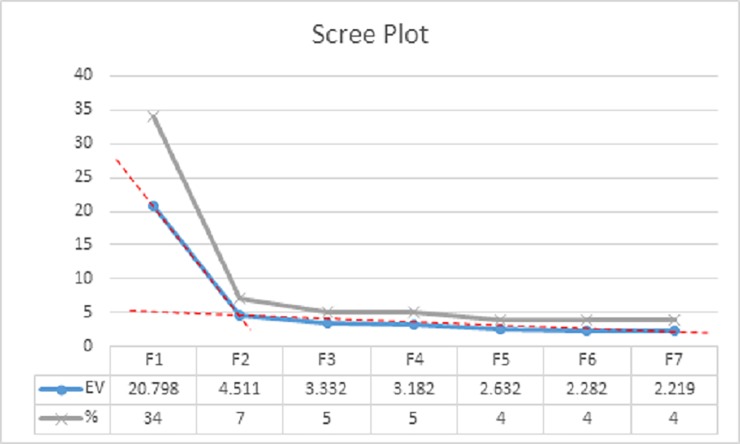
Scree plot dotted line assists to identify the inflection point.EV = eigenvalue. % = Percentage of explained variance.